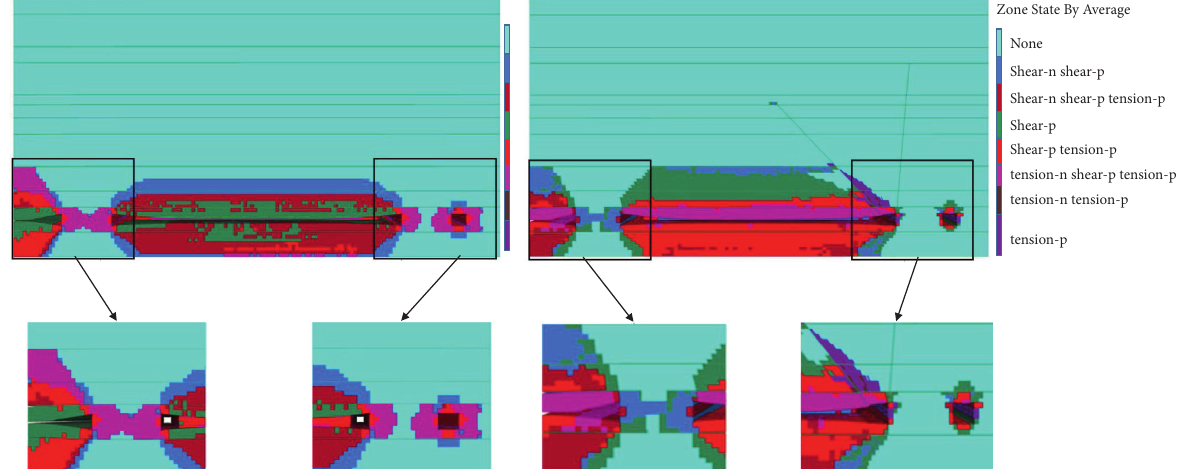
Figure 8: Variation cloud map of plastic zone of surrounding rock in the roadway (a) before and (b) after hydraulic